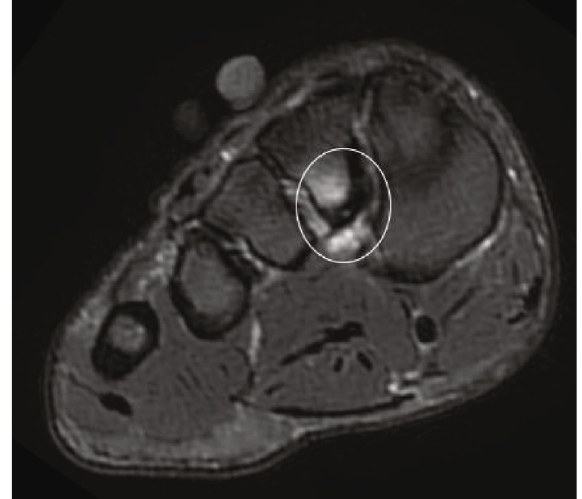
Figure 3: A 29-year-old soccer player with progressive midfoot pain. Axial PDFS at the plantar Lisfranc attachment to the second metatarsal base. There is oedema signal associated with the plantar Lisfranc ligament. There is also plantar cortical thickening with intracortical fl uid signal